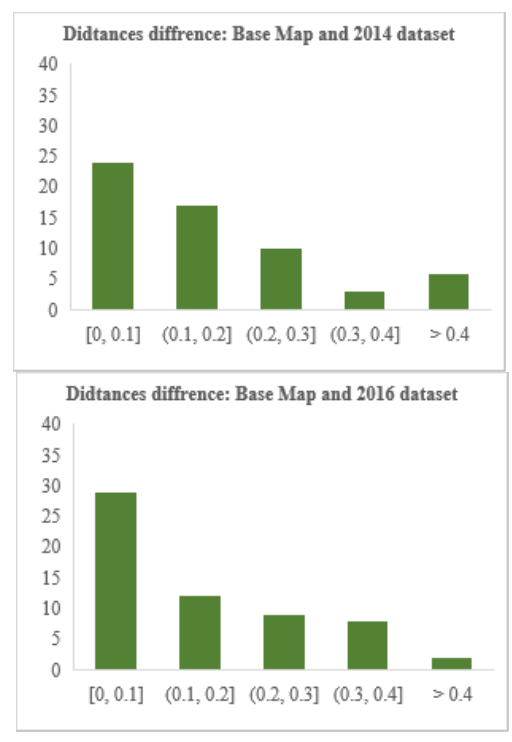
Figure 5. Histograms of differences between distances measured on different oblique image datasets and the base